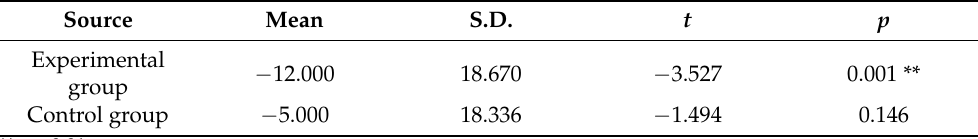
Table 3. Results of paired samples t -test on learning achievement for both groups.